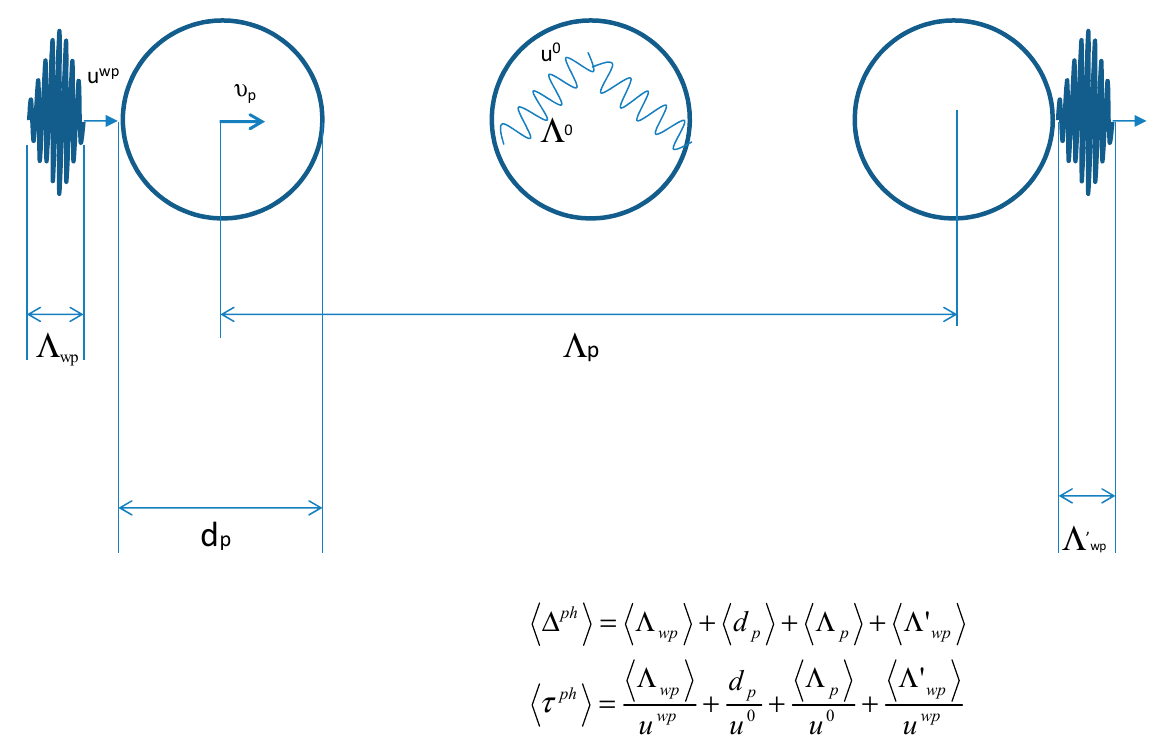
Figure 2. Close-up of the wave packet— liquid particle interaction shown in Figure 1a. Only the first part of the interaction is represented, i.e., that during which the wave packet transfers momentum and energy to the liquid particle (Modified after Peluso, F., [18]).